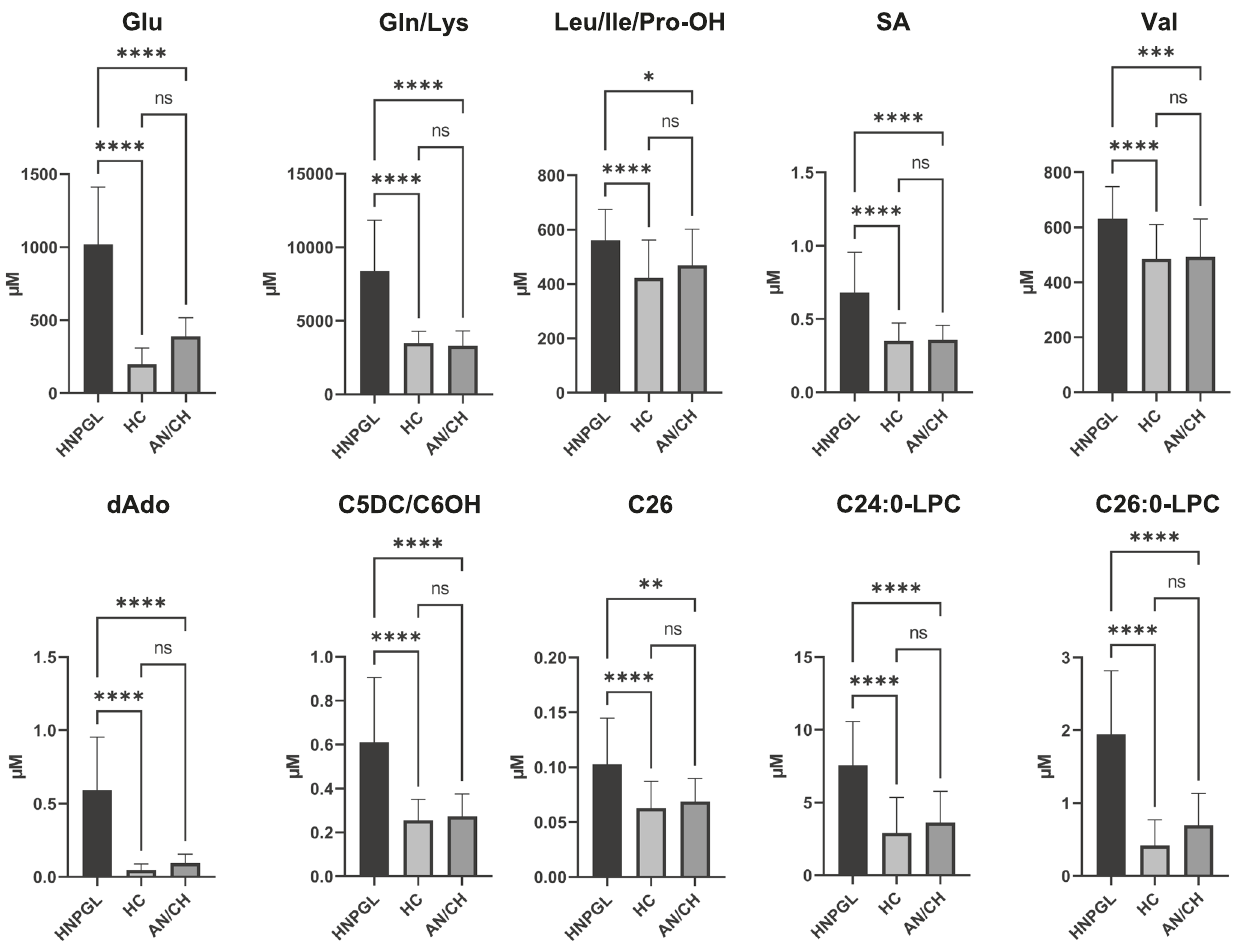
Fig. 3 Bar charts for the metabolites that most impacted on the partial least square discriminant analysis (PLS-DA) model. Bar charts show the plasma concentrations of the metabolites with VIP values > 1 in head and neck paraganglioma patients (HNPGLs), healthy controls (HCs), and patients affected with acoustic neuroma or cholesteatoma (AC/CH). Only the metabolites that presented signi fi cant differences by t-test are shown (* p < 0.05; ** p < 0.01; *** p < 0.001; **** p < dAdo and C26:0-LPC in plasma versus dried venous and capillary blood spotted on paper The analysis of dAdo and C26:0-LPC in plasma versus paired dried venous blood spotted on paper (DVB, n = 21 samples) revealed a moderate correlation between dAdo plasma and DVB levels, supported by Pearson r (0.49) and p value (0.0259), while no correlation emerged for C26:0-LPC. Finally, dAdo levels were assessed in DVBs from HNPGL patients and HCs versus dried capillary blood (DCB) samples, also spotted on fi lter paper, from paired HCs. This con fi rmed that the levels in the DVB and paired DCB samples were comparable, while there were statistically signi fi cant differences between the DVBs from the HNPGL patients and the DVBs ( p = 0.034) and the DCBs ( p = 0.017) from the HCs